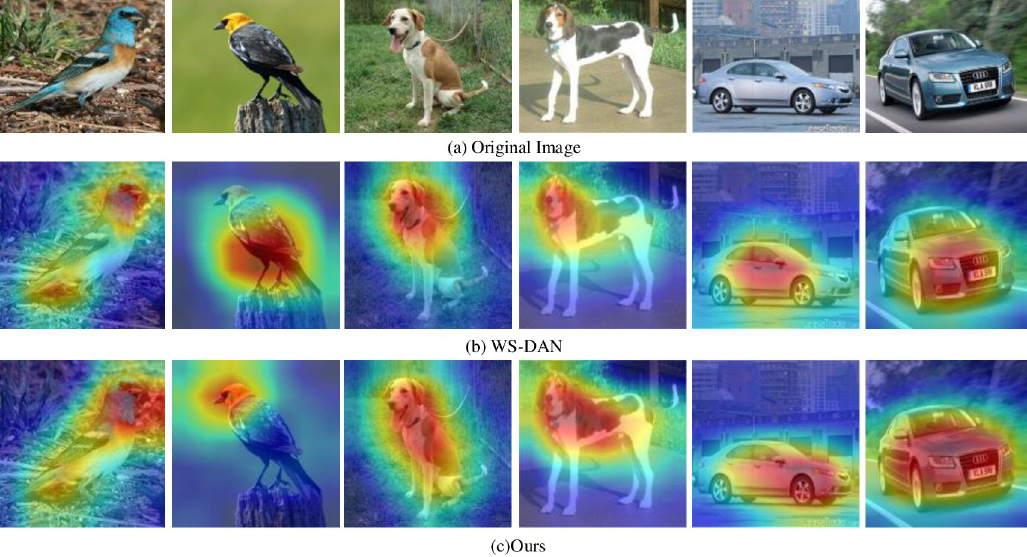
Fig 8. Visualization of